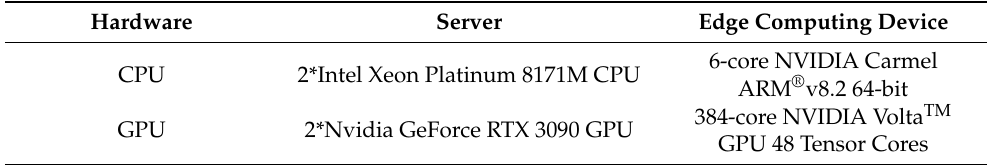
Table 2. Hardware comparison between the server and the edge computing device.